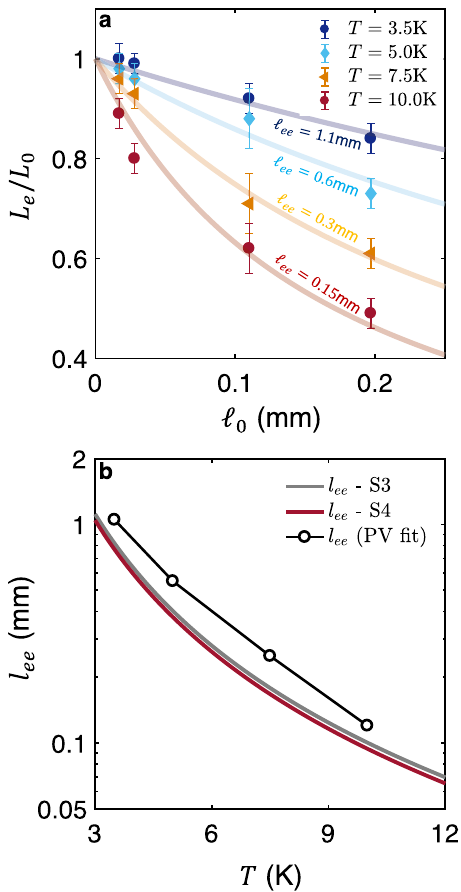
Fig. 6 The evolution of the Wiedemann-Franz correlation with the ratio of momentum-relaxing and momentum conserving mean free paths. a The electronic Lorenz number L e at T = 10K, normalized by the Sommerfeld value L 0 , plotted as a function of the residual mean free path ℓ 0 at various temperatures. The solid lines correspond to a fi t given by the equation L = L ¼ 1 = ð 1 þ ‘ =‘ Þ proposed by Principi and Vignale (PV) 3 . ℓ ee 0 0 the zero-temperature Drude mean free path while ℓ ee ( T ) is the typical distance traveled by a charge carrier in-between two momentum- conserving collisions. Error bars are de fi ned from the experimental uncertainty on L e featured in Fig. 5a. b Comparison of l ee determined by the fi t to the aforementioned PV formula and what is yielded by assuming that the difference between the two T -square resistivities represents the fraction of collisions which conserve momentum. In that case, ‘ ¼ ‘ 0 ρ 0 ee ð B 2 (cid:2) A 2 Þ T 2